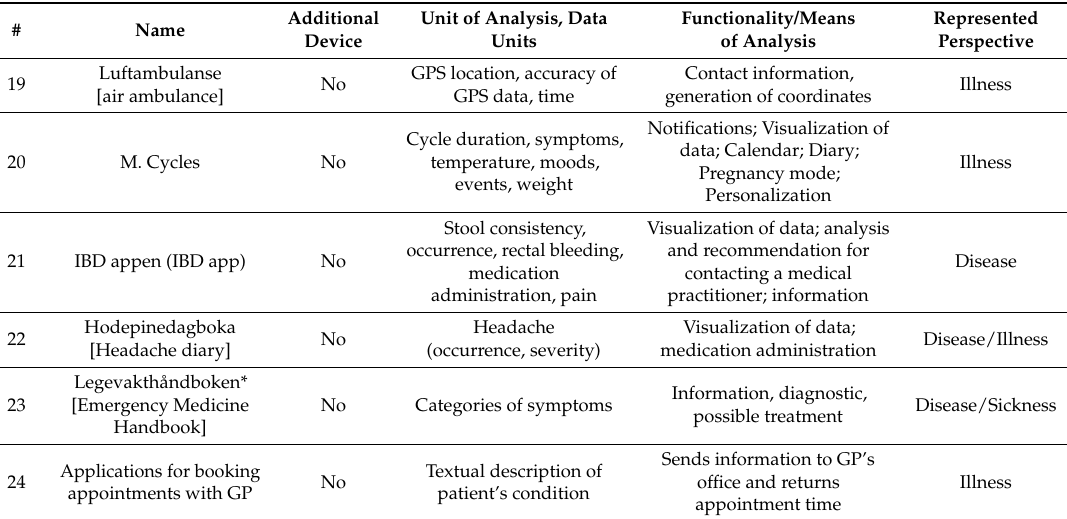
Table 3. Overview of the applications that the interviewed patients have used/were using. Applications developed with medical practitioners as intended users are marked with